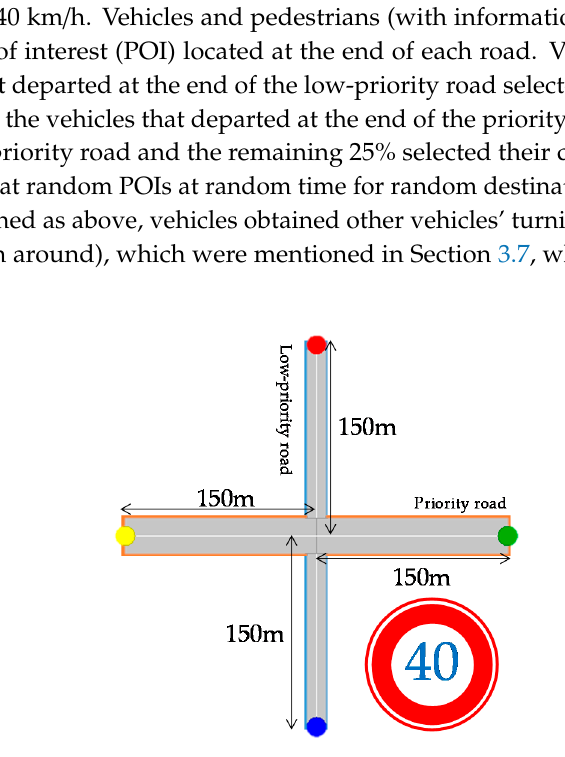
Figure 9. Simulated field.